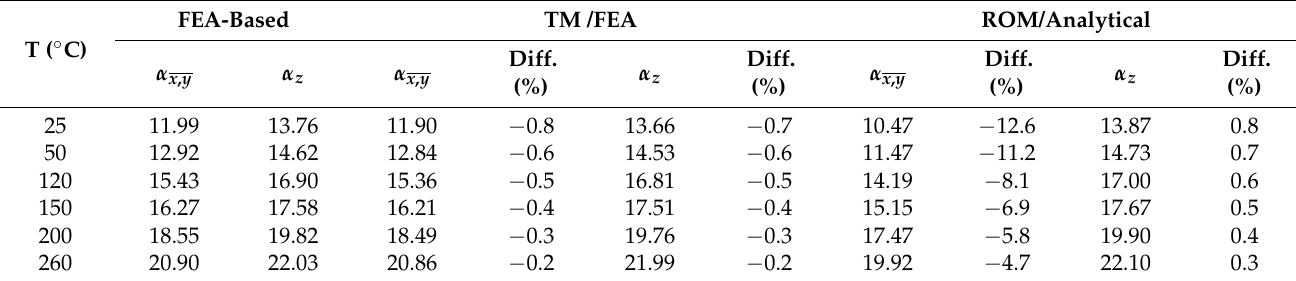
Table 3. Comparison of the calculated effective CTEs using three different